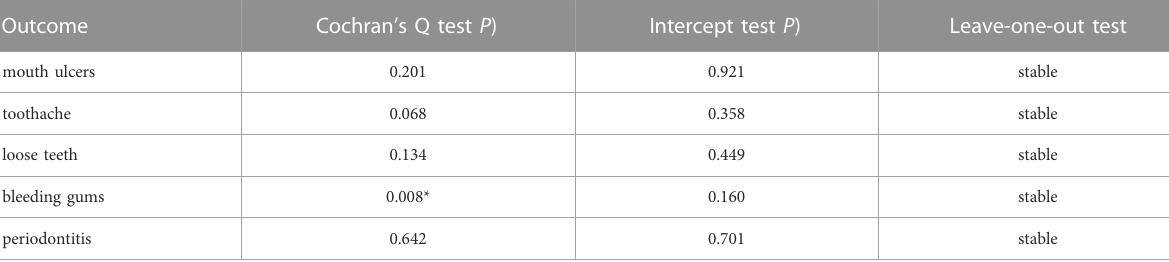
TABLE 2 Sensitivity analysis of the causal association between GERD and oral